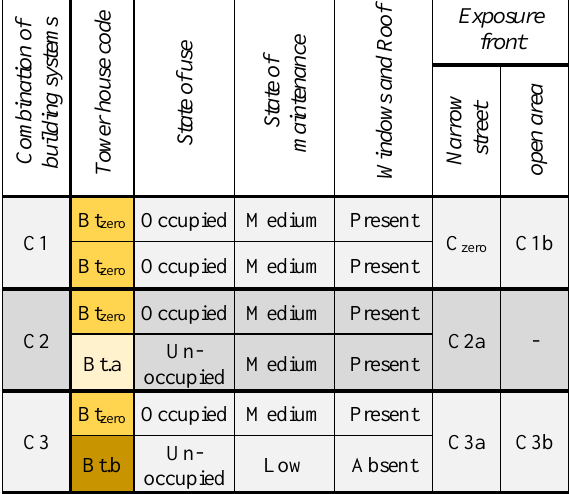
Table 2. Combination of building systems and description